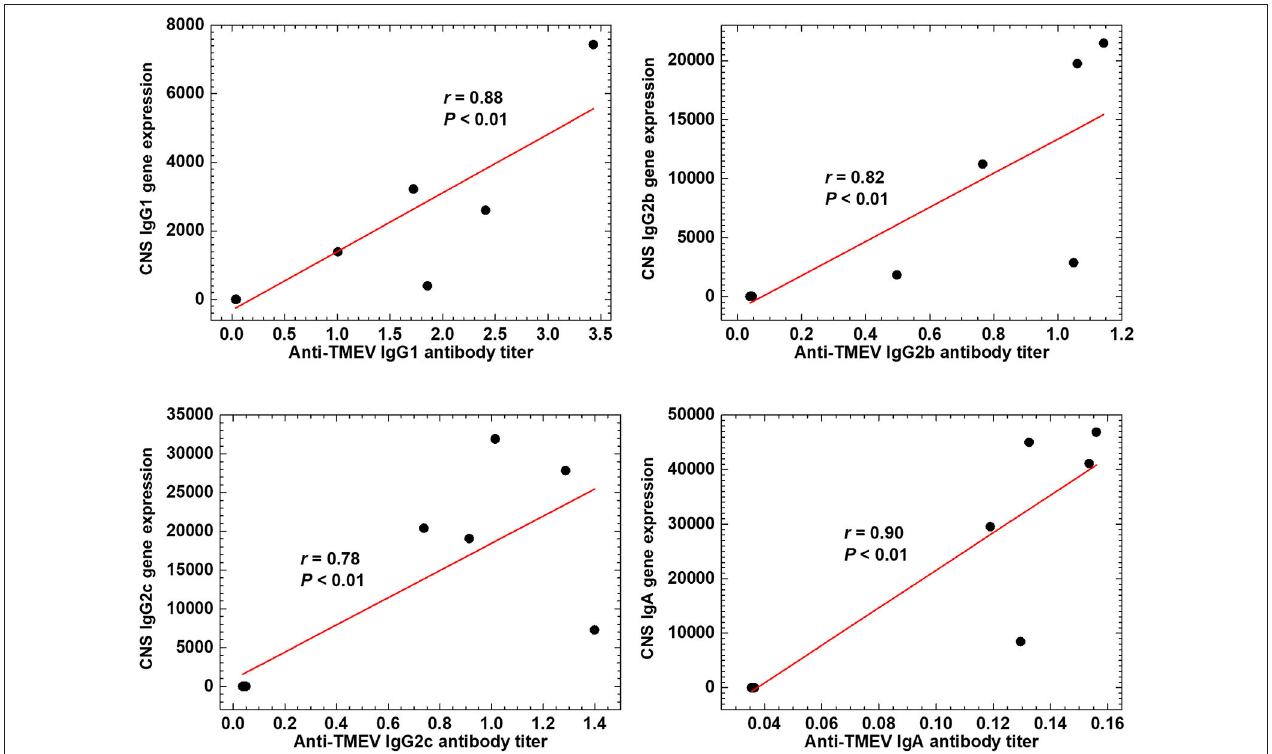
FIGURE 7 | Anti-TMEV antibody isotype responses. Correlations between CNS Ig isotype expressions and serum anti-TMEV isotype antibody titers. During the chronic phase of TMEV infection, gene expression levels of constant regions of heavy chains of IgG1 ( Ighg1 ), IgG2b ( Ighg2b ), IgG2c ( Ighg2c ), and IgA ( Igha ) were correlated with their anti-TMEV antibody isotype titers, significantly ( P < 0.01, n = 10). We quantified the gene expression levels and anti-TMEV antibody titers by RNA-seq and enzyme-linked immunosorbent assays (ELISA, absorbance at 490nm),